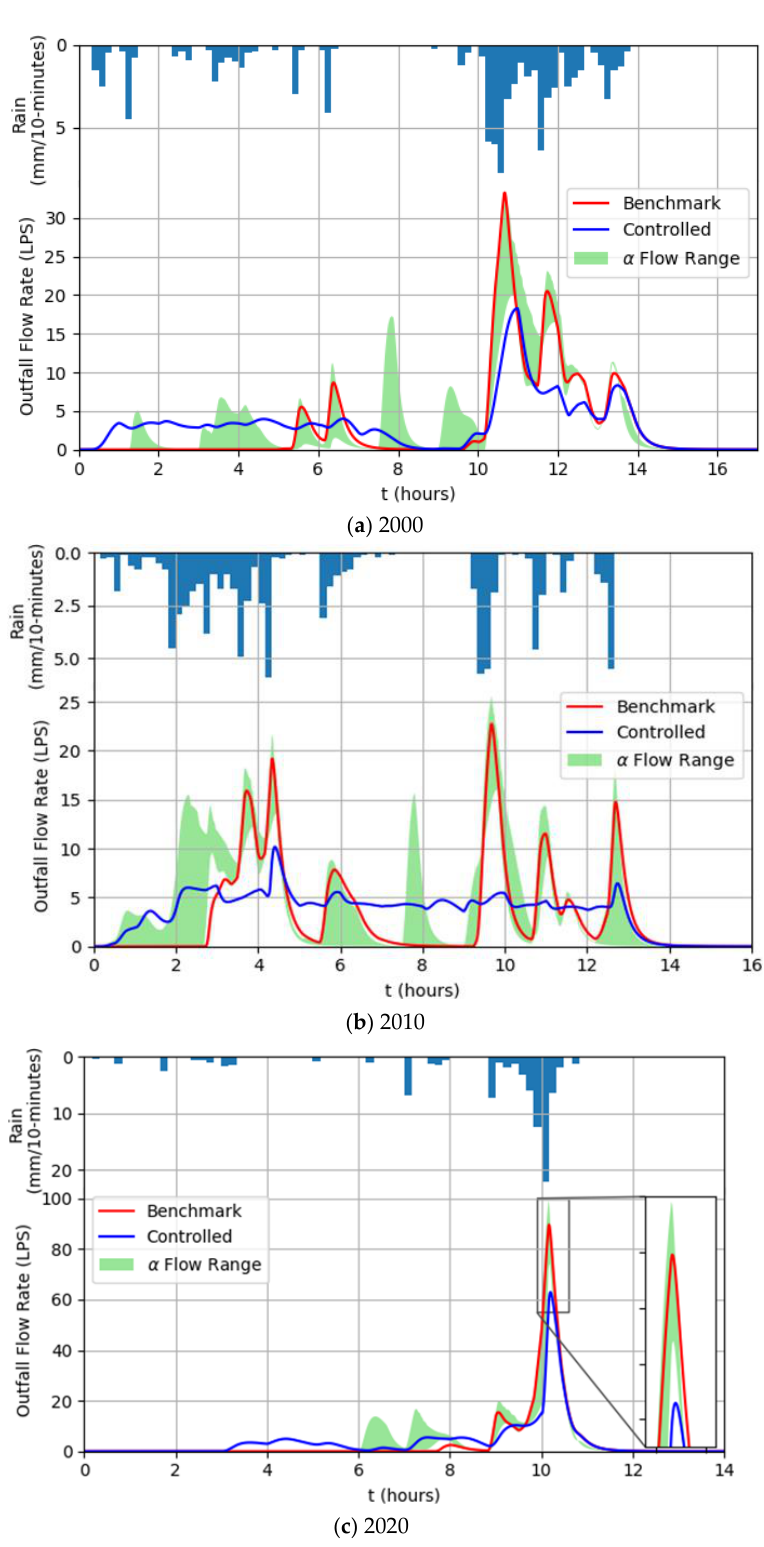
Figure 8. Comparison of the generated flow patterns from the benchmark run (red), the suggested controlled release optimization scheme (blue) and α parameter method (green area ), tested on three recorded rain events (see Section 2.2.1) ( a ) 5th January 2000; ( b ) 25th – 26th February 2010; ( c ) 20th – 21st November 2020 (plots were enlarged at t = 10 h — time of the recorded peak flow). Note that the α flow range upper and lower bounds are the maximum and minimum flow generated by the entire α parameter range (0.0 – 0.9).